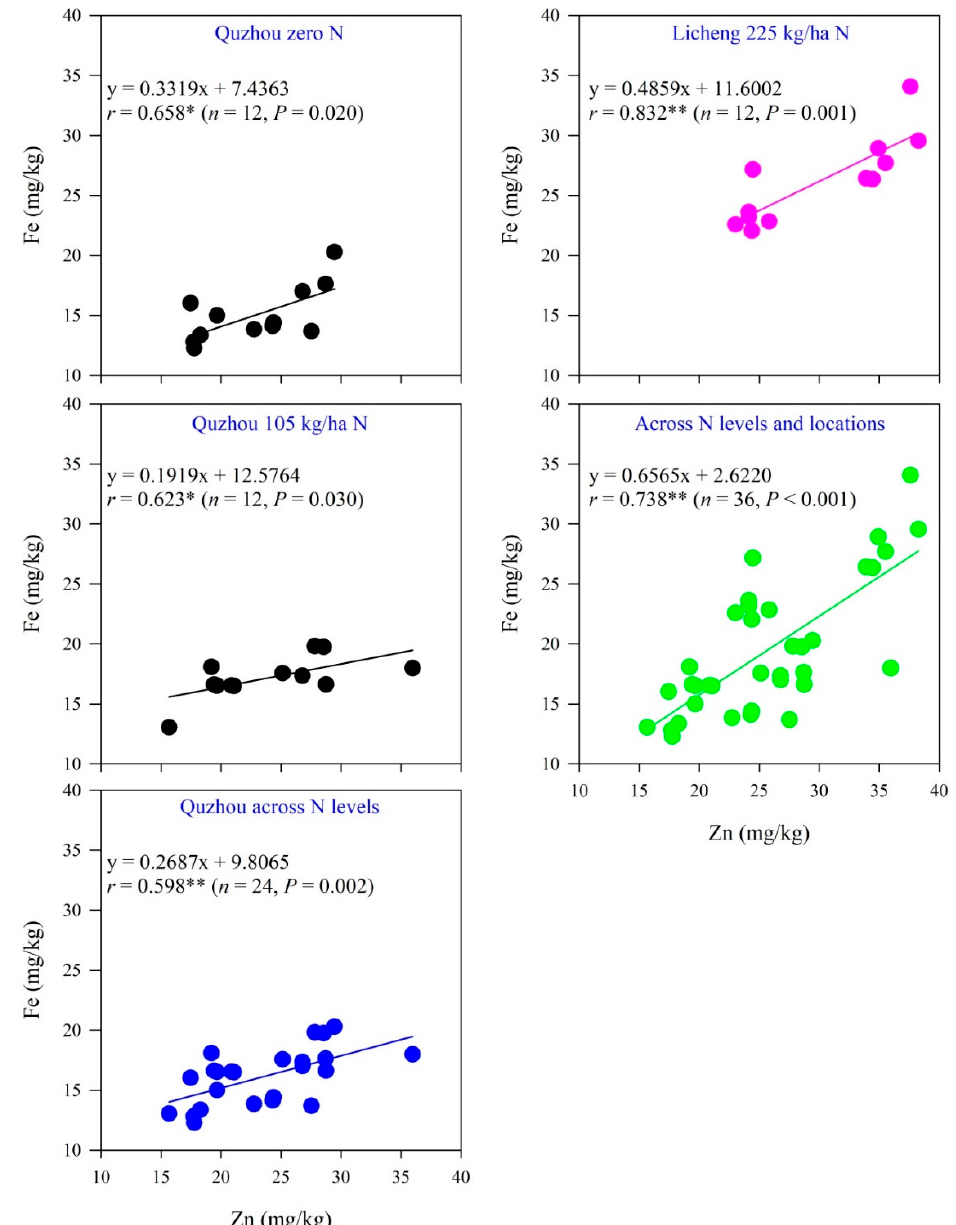
Figure 1. Relationships between Zn and Fe concentrations in maize grains across all foliar spraying treatments at different nitrogen (N) application rates and different experimental locations. * indicates significance at p ≤ 0.05; **, significance at p ≤ 0.01.